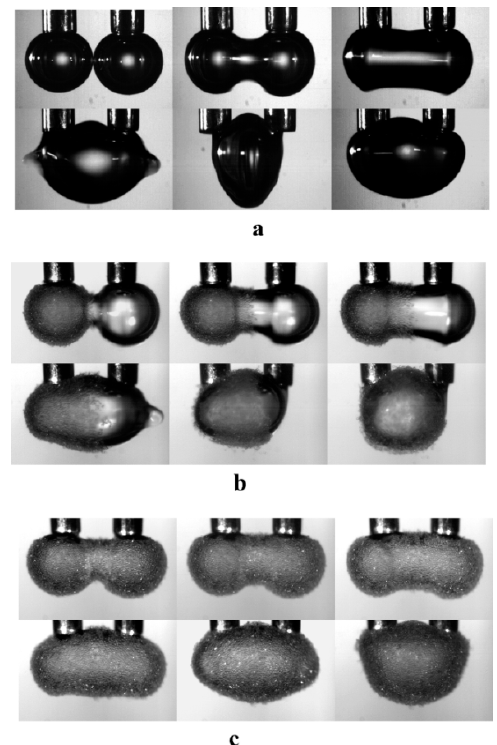
Figure 6. Coalescence behaviour of pairs of bubbles of equal volume generated at the tips of adjacent capillaries (with diameters of 1.07 mm). The time between the photographs is about 0.5 ms. ( a ) Bubbles with pristine surfaces initially oscillate, as the neck that forms between them extends as an expansion wave along the surface of the merging bubble. The merged bubble relaxes into a spherical shape within a few milliseconds; ( b ) In the case where one bubble is coated with silanised glass beads (with a median radius of 33 μ m), the oscillations of the merging bubbles drive the beads into the centre of the bubble surface. They form a belt around the bubble surface, leaving each of the ends uncoated. The amplitude of the oscillations gradually decreases until the merged bubble reaches a stable stationary state; ( c ) Two fully coated bubbles coalesce together smoothly. The oscillations of the merging bubble are damped, presumably due to the attached particles making the bubble surface relatively rigid. Reprinted with permission from [81]. Copyright (2008) American Chemical Society.